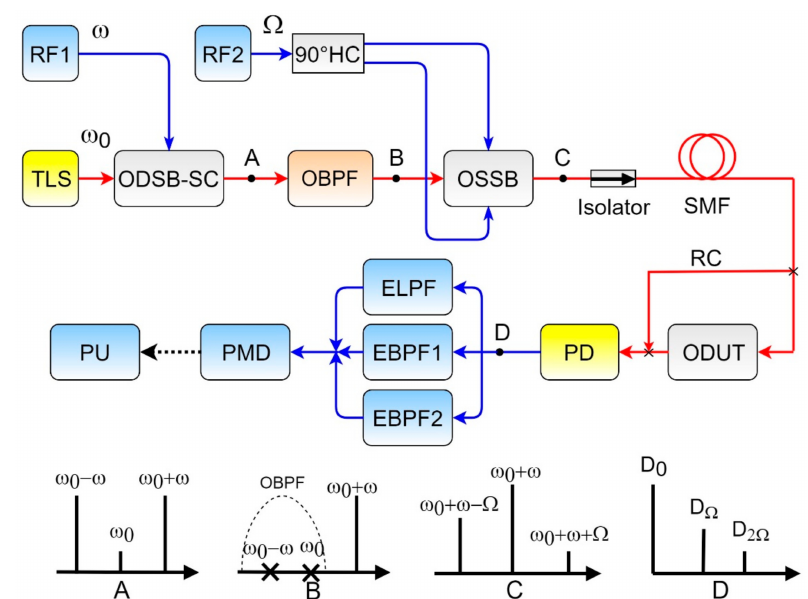
Figure 14. TLS—tunable laser source; RF1—Scanning Radio Frequency; ODSB-SC—ODSB-signal